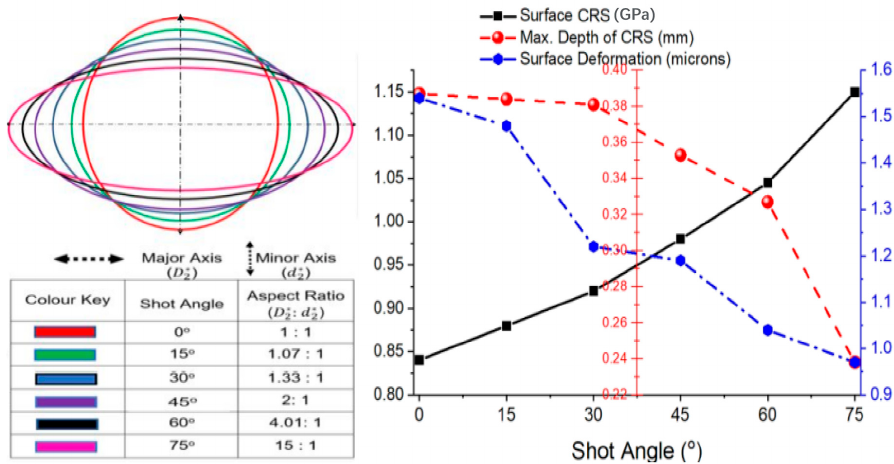
Figure 11. Variable shot angle effects on residual stress